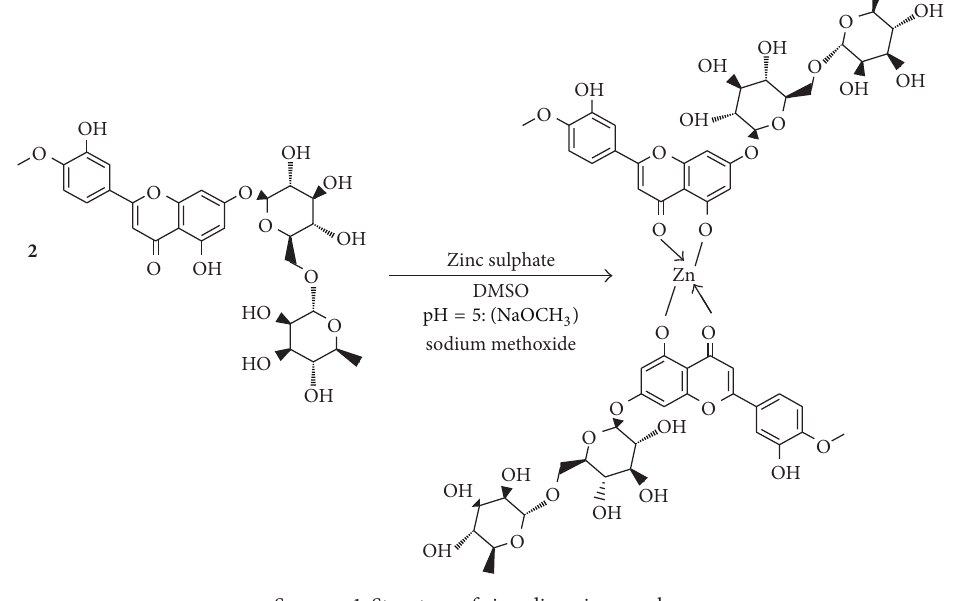
Scheme 1: Structure of zinc-diosmin complex.